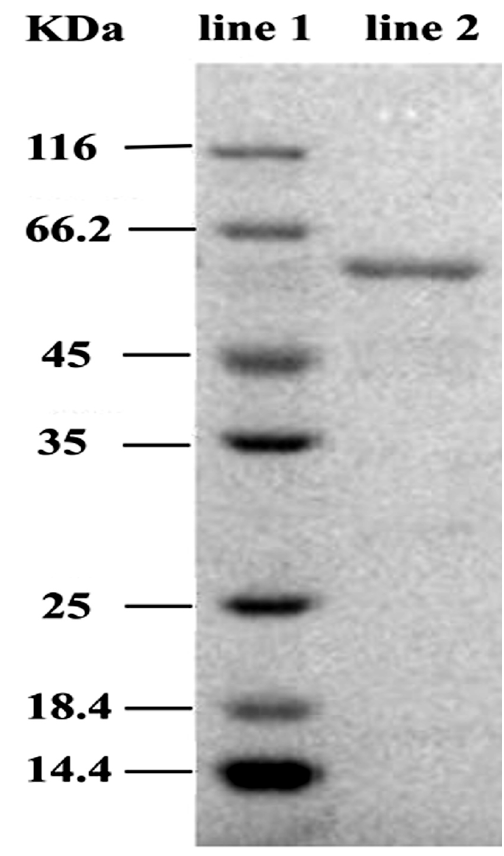
Fig. 5. Molecular weight of laccase derived from Streptomyces syiceus strain KN3 line 1: Molecular weight marker Line 2: FPLC purified